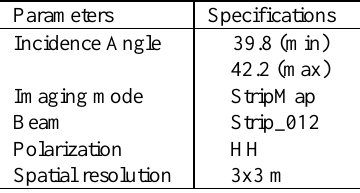
Table 1. Specifications of TerraSAR-X data used for study area